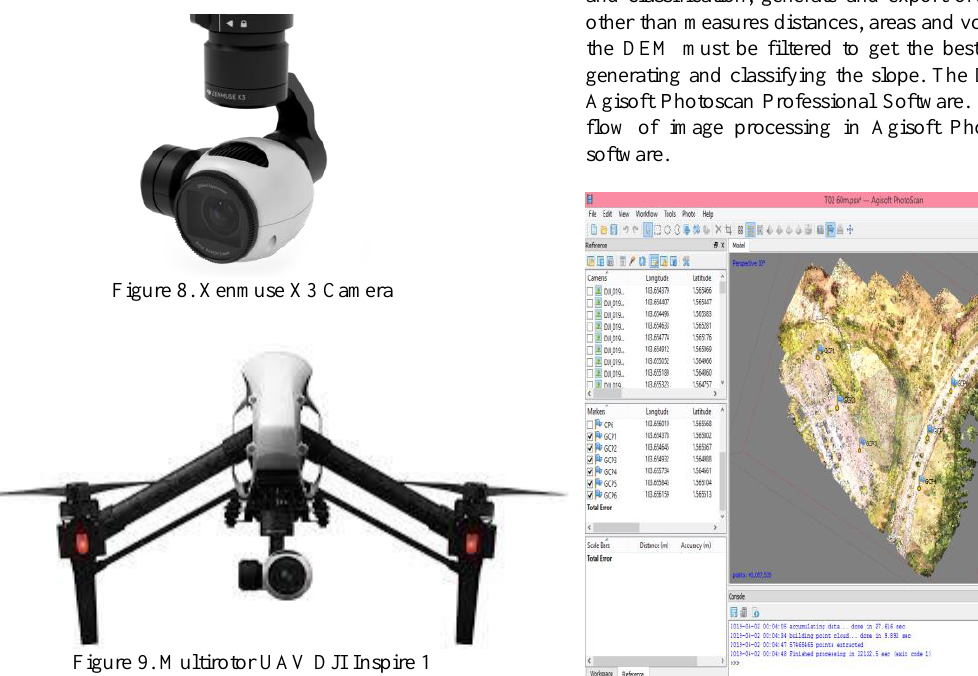
Figure 9. Multirotor UAV DJI Inspire 1